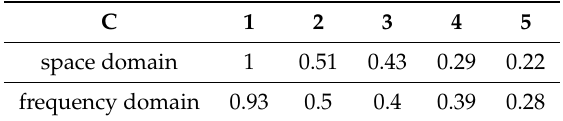
Table 2. Accuracy of subjects counting using the CSI distribution features and the KL divergence approach in space (10) and frequency domains